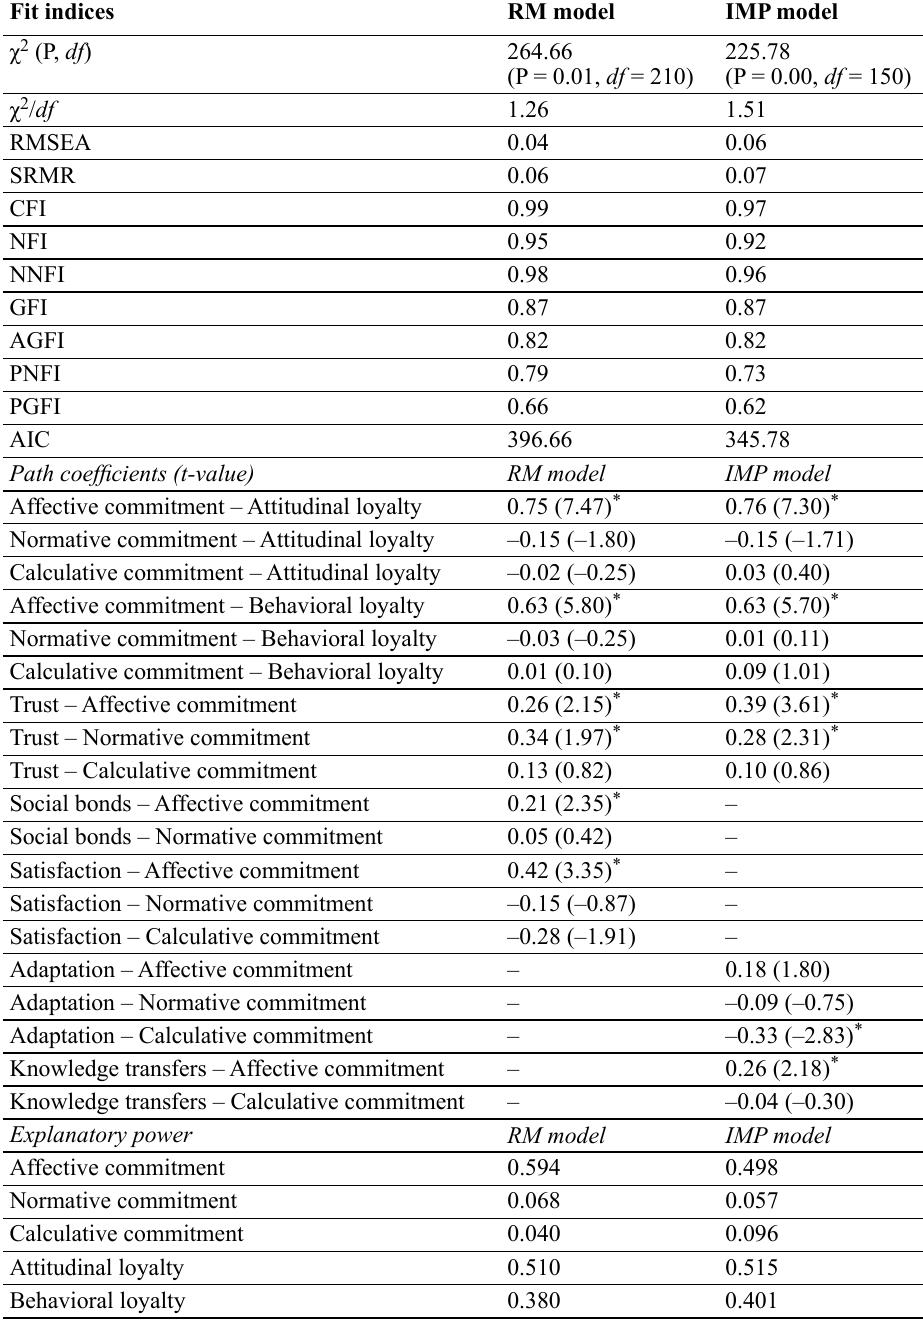
Table 4. Overall fit indices, path coefficients and explanatory power of the